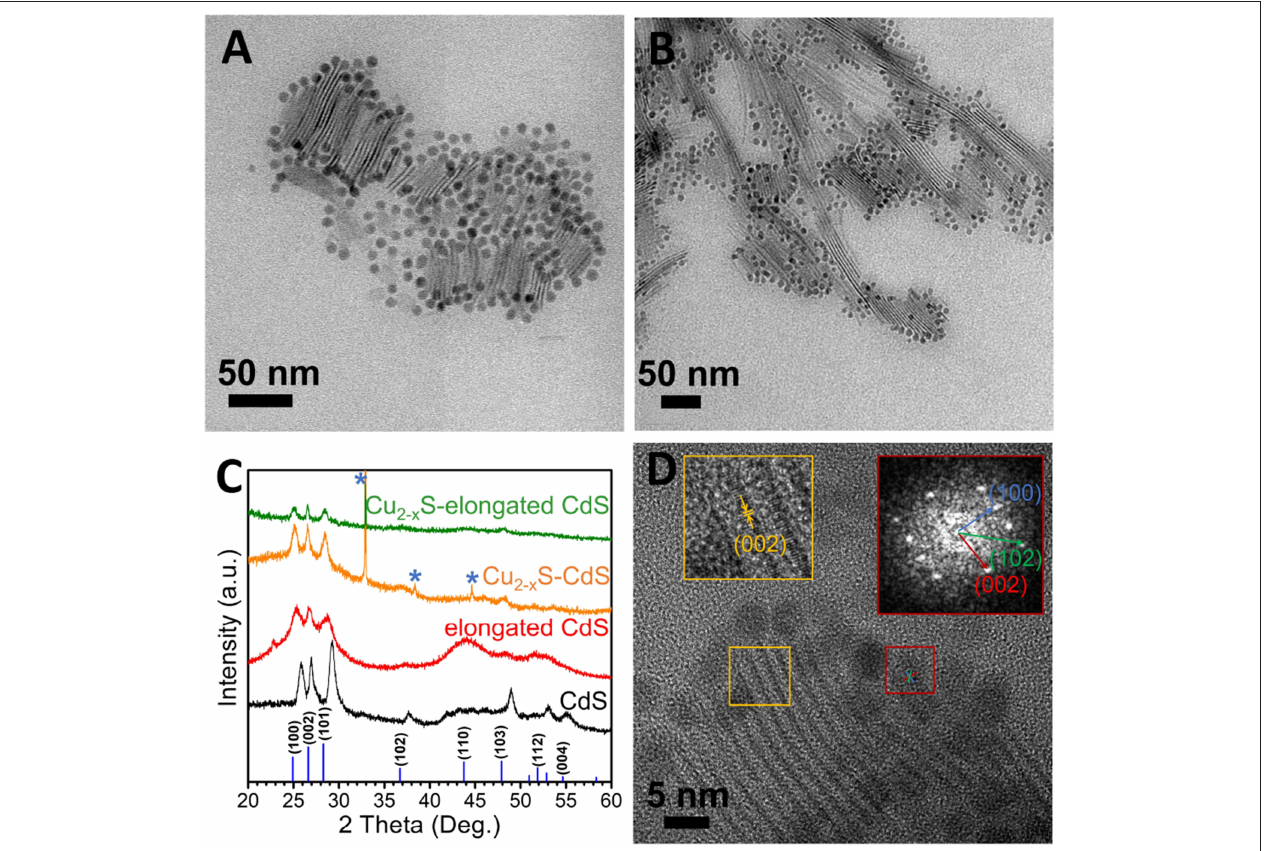
FIGURE 3 | Growth of Cu 2 − x S on CdS NPLs. TEM images of (A) Cu 2 − x S–CdS NPLs and (B) Cu 2 − x S–elongated CdS NPLs, (C) XRD patterns, and (D) HRTEM image of Cu 2 − x S–CdS NPLs. The sharp peaks marked by asterisks in (C) originate from the substrate. The left inset in (D) is an enlargement of the area marked in yellow with hexagonal CdS (002) plane labeling. Right inset is an FFT analysis of the area marked in red of Cu 2 − x S, corresponding to a hexagonal symmetry, and (100), (002), and (102) planes of high chalcocite Cu 2